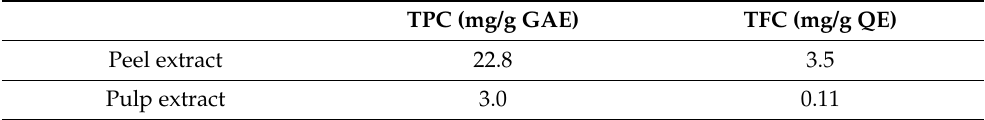
Table 1. Quantitative measurement of phenolics and flavonoids in the peel and pulp extracts of H. undatus